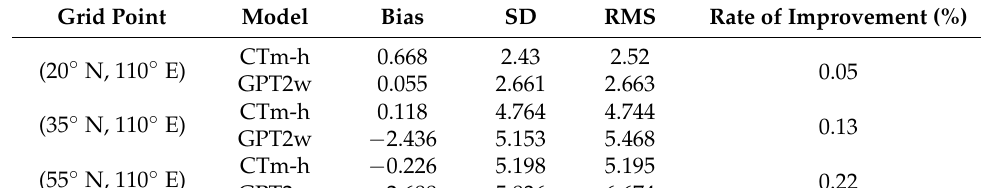
Table 1. Precision comparison of three grid points between CTm-h and GPT2w (K).